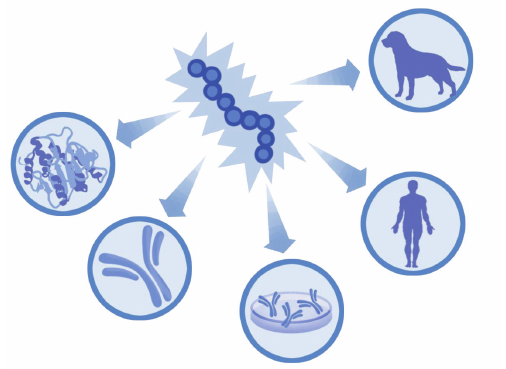
Figure 2: The broader relevance of Tregitopes is shown from left to right (counter clockwise). Tregitopes may be incorporated into protein drugs and monoclonal antibodies, to suppress antither- apeutic protein immune responses. Removing Tregitopes from autologous antigens would improve the ability of protein engineers to develop effective antibodies for target (autologous) antigens, and engineering Tregitope-depleted antibodies may improve the delivery of vaccine antigens. As described in this paper, Tregitopes may represent a new therapeutic option for autoimmune disease. In addition, Tregitopes could be used to suppress autoimmune diseases in companion